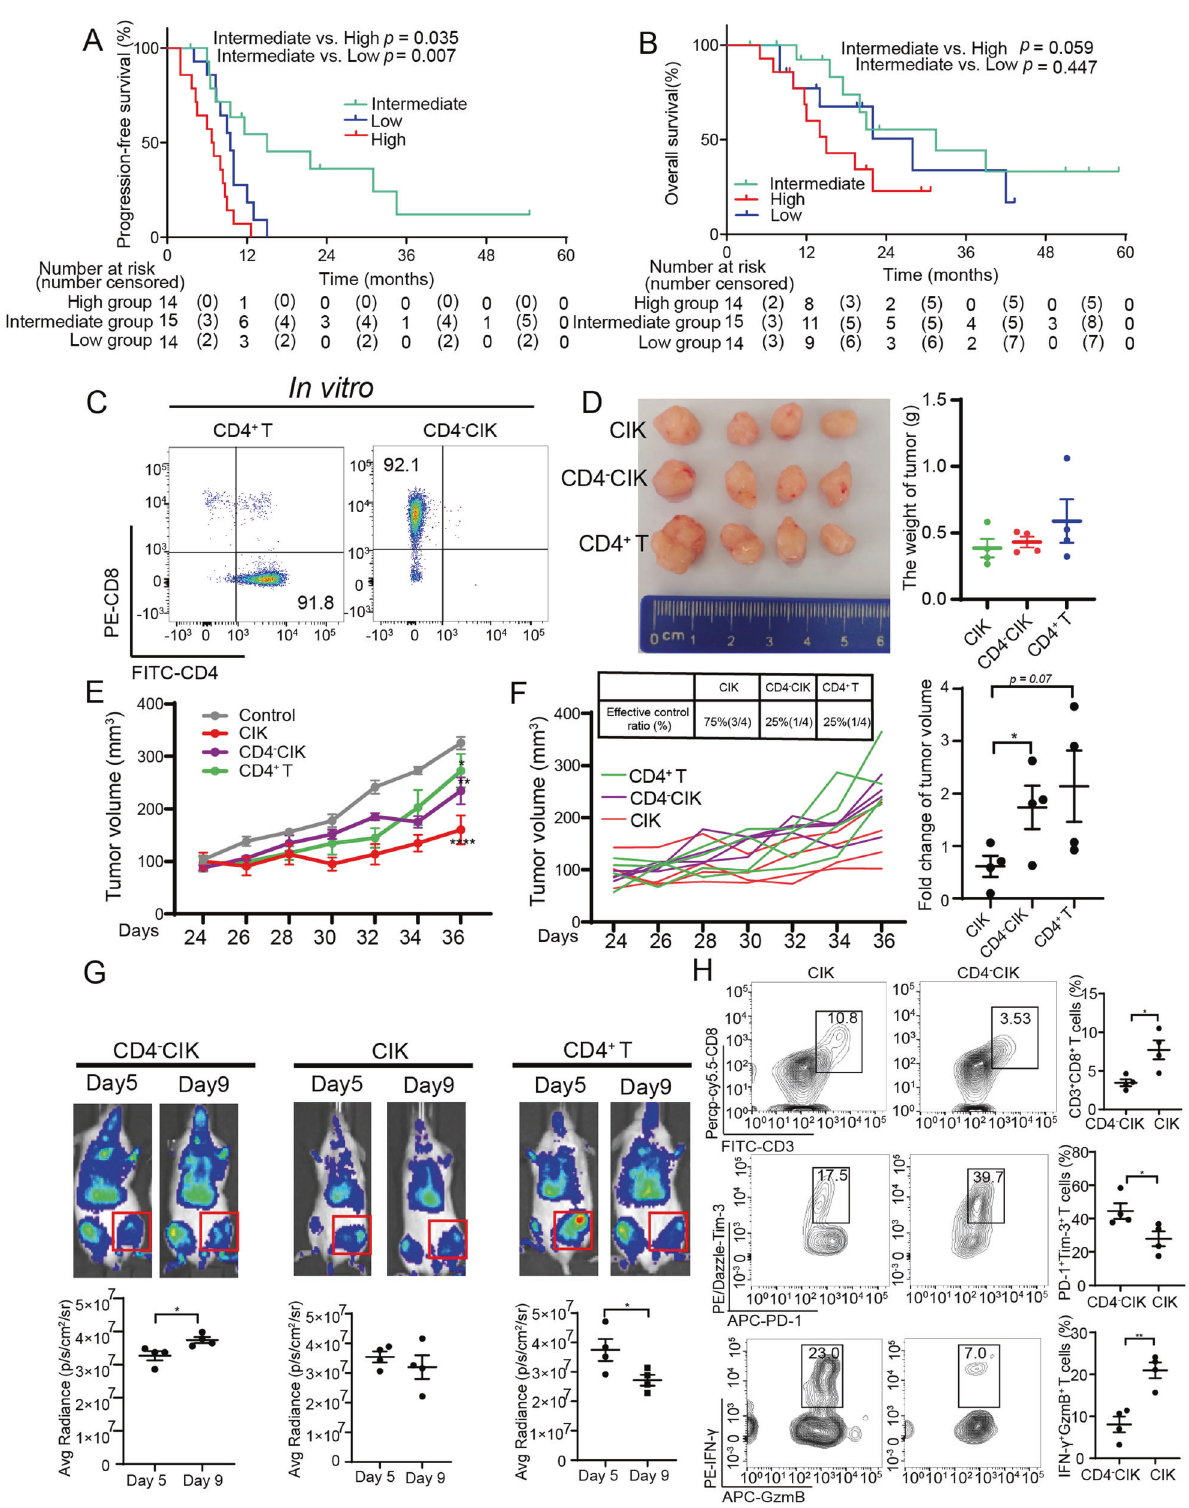
Fig. 1 The percentage of CD4 + T cells correlated with clinical prognosis and function of CIK cells. A Kaplan – Meier estimates of progression- free survival in the three (high, intermediate, and low) groups. B Kaplan – Meier estimates of overall survival in the three (high, intermediate, and low) groups. C Flow cytometric quality assessment of CIK cells after 14 days of ex vivo expansion before adoptive transfer to tumor- burdened NSG mice. D – F Subcutaneous growth of tumor cells (A549) in each group of mice ( n = 4) treated with CD4 + T, CD4 - CIK, and CIK cells. G Bioluminescent imaging of NSG mice from three groups treated with T-cell tracer. H Flow cytometric analysis of IFN- γ , GzmB, PD-1, and Tim-3 expression in CD3 + CD8 + T cells. Error bars indicate SEM, * P < 0.05, ** P < 0.01, *** P < 0.001, and **** P < 0.0001 (Kaplan – Meier, one-way ANOVA or Student's t